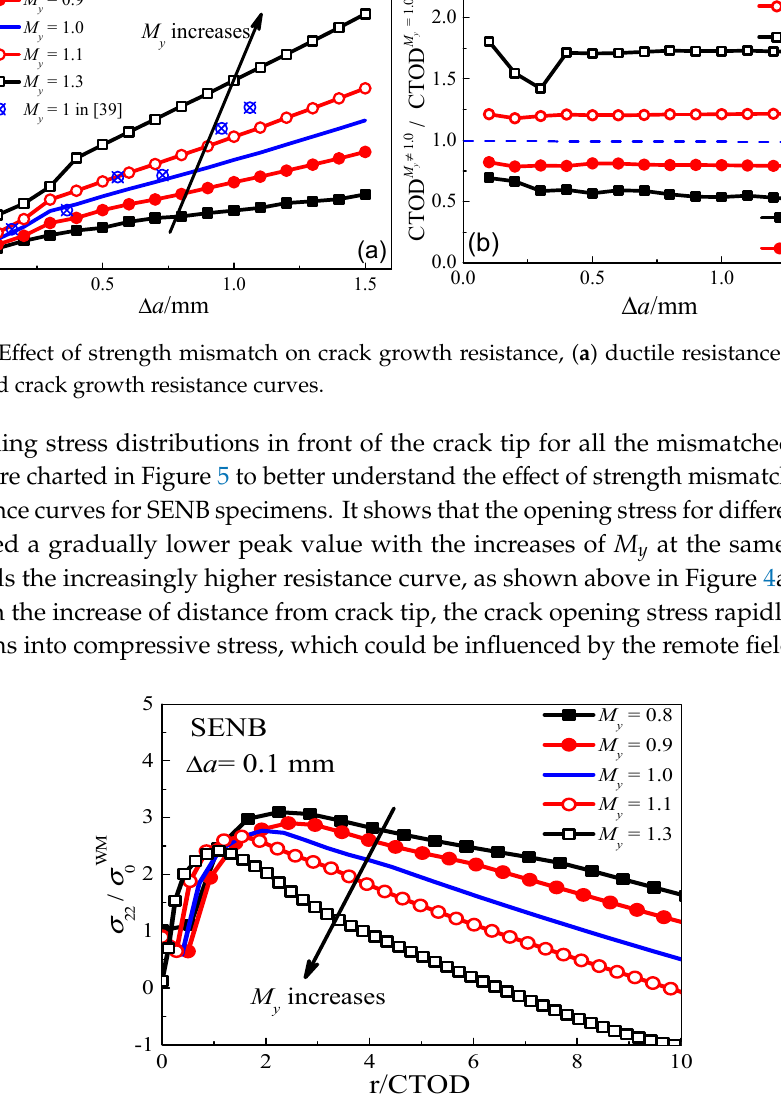
Figure 6. Equivalent plastic strain distributions ahead of the current crack tip for all the mismatched SENB specimens, ( a ) ∆ a = 0.1 mm; ( b ) ∆ a = 0.5 mm; and, ( c ) ∆ a = 1.5 mm. 3.2. SENT In this study, the SENT specimens with shallow ( a /W = 0.2) and deep ( a /W = 0.5) cracks are considered for comparison. Figure 7 shows the crack growth resistance curves for variously mismatched SENT specimens. It can be observed that the resistance curves significantly increase with the increase of strength mismatch levels for both shallow and deep-cracked SENT specimens, which is consistent with that of the SENB specimens. The normalized crack growth resistance curves (CTOD My ≠ 1.0 /CTOD My = 1.0 ) were also studied, and similar results as that of SENB have been observed.